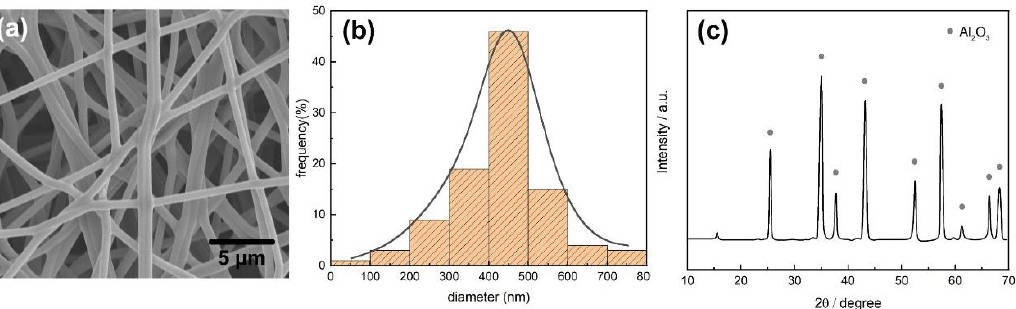
Figure 2. ( a ) SEM image of the Al 2 O 3 film. ( b ) The diameter distribution of the Al 2 O 3 film. ( c ) XRD patterns of the Al 2 O 3 nanofibers.